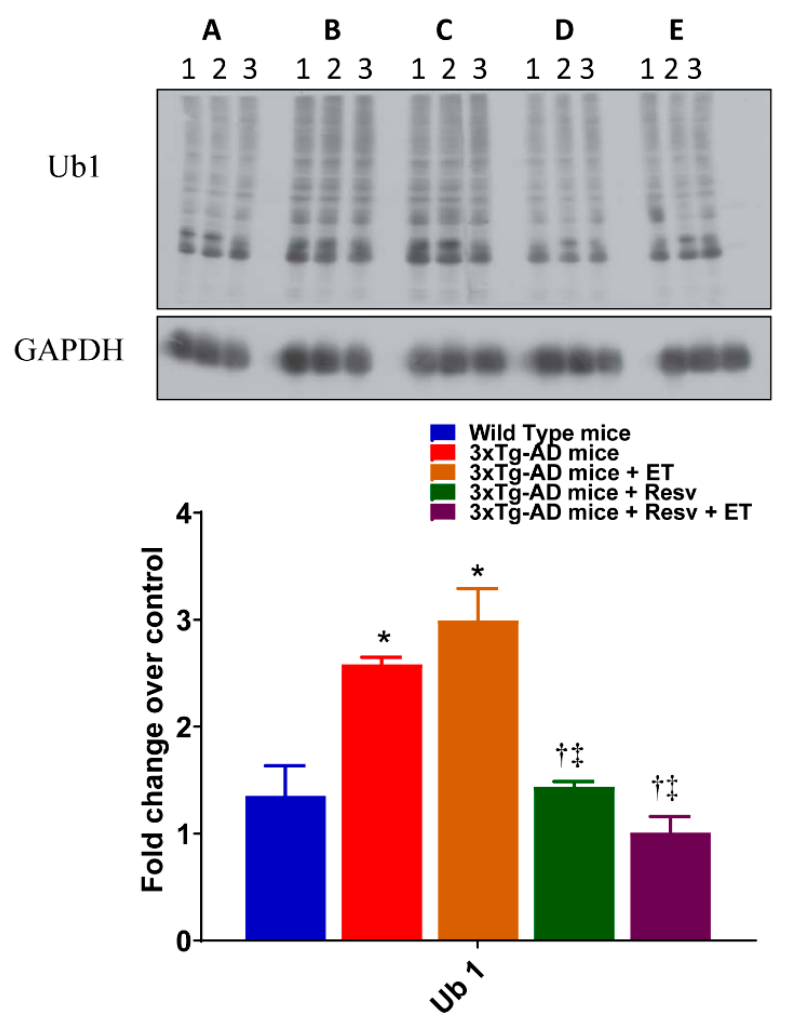
Figure 7. The effects of Resv and ET on protein ubiquitination. Treatment with Resv or Resv with ET decreased protein ubiquitination, expressed as Ub1. Corresponding densitometry measurements: A, WT mice; B, 3xTg-AD mice; C, 3xTg-AD mice + ET; D, 3xTg-AD mice + Resv; E, 3xTg-AD mice + Resv + ET. AD, Alzheimer’s disease; ET, exercise training; Resv, resveratrol. Data presented as mean ± SD for 3 mice per group. *, compared to WT mice, p < 0.05; † , compared to 3xTg-AD mice, p < 0.05; ‡ , compared to 3xTg-AD mice + ET, p < 0.05.